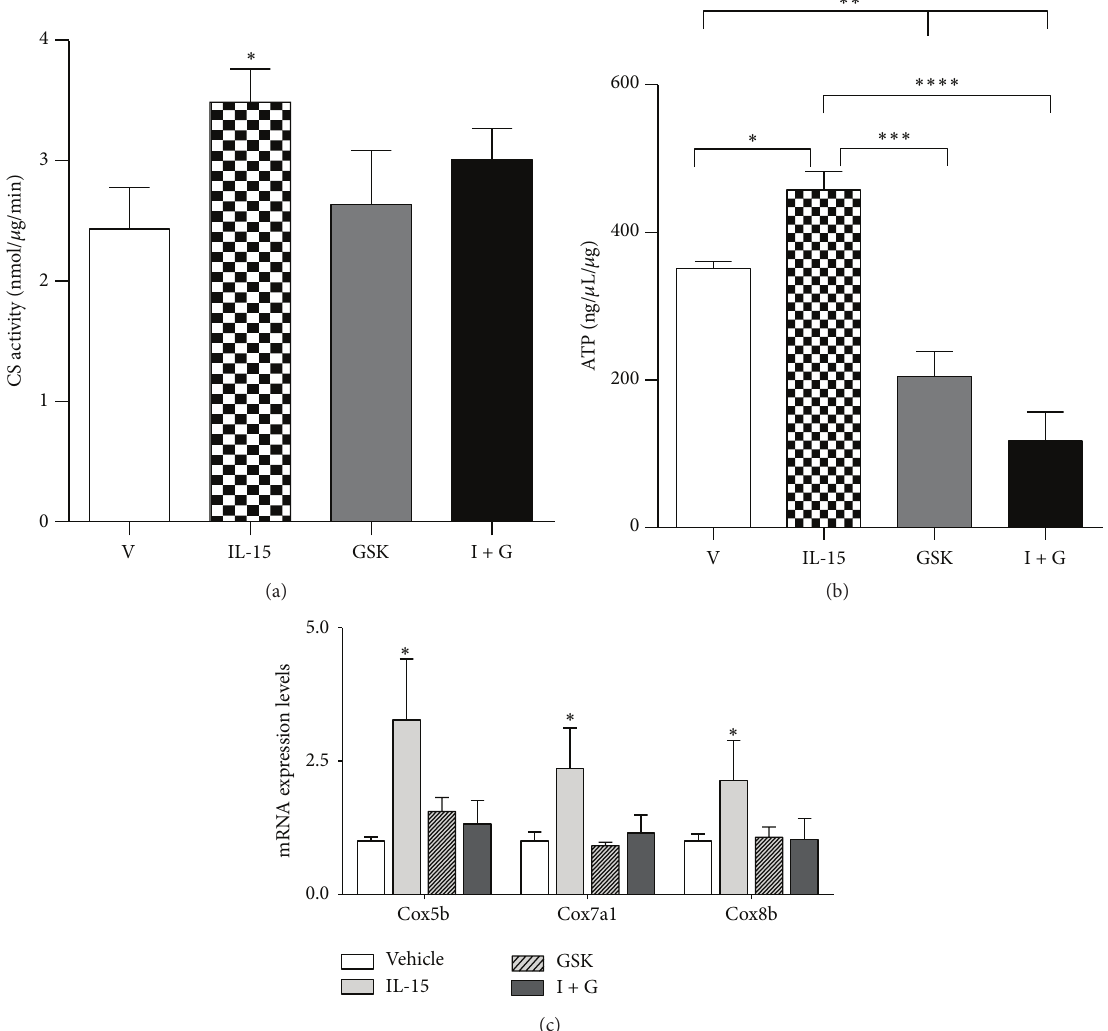
Figure 6: Involvement of PPAR 𝛿 in IL-15 mediated mitochondrial activity. (a) Citrate synthase (CS) activity; (b) total intracellular ATP content; (c) mRNA expression of cytochrome C oxidase isoforms Cox5b, Cox7a1, and Cox8b. Assessments were carried out on total cell lysates from C2C12 SKM cells following treatment every other day, for 6 days, with either vehicle control (DMSO), IL-15 (100ng/mL), 1 𝜇 M of the PPAR 𝛿 inhibitor (GSK-3787), or IL-15 + GSK-3787 (I + G). All values are displayed as means ± SEM, 𝑛 = 6 per group, ∗ different from vehicle control group; 𝑃 < 0.05 ; ∗∗ different from all groups, 𝑃 < 0.01 ; ∗∗∗ different from IL-15 group, 𝑃 < 0.001 ; ∗∗∗∗ GSK different from IL-15 group, 𝑃 < 0.001